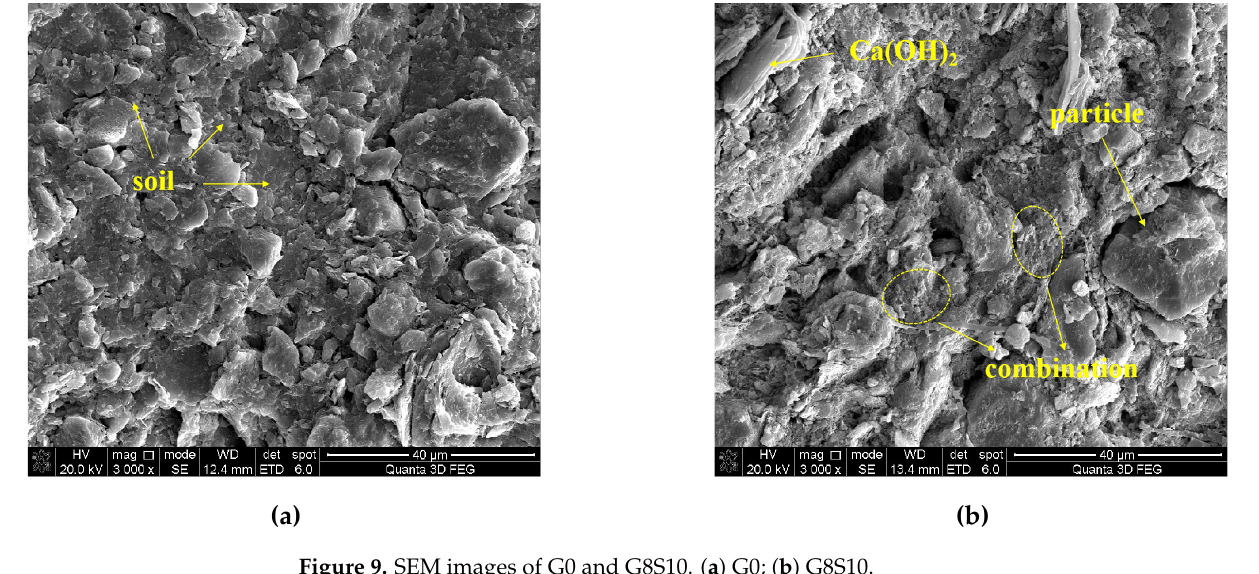
Figure 9. SEM images of G0 and G8S10. ( a ) G0; ( b ) G8S10 .